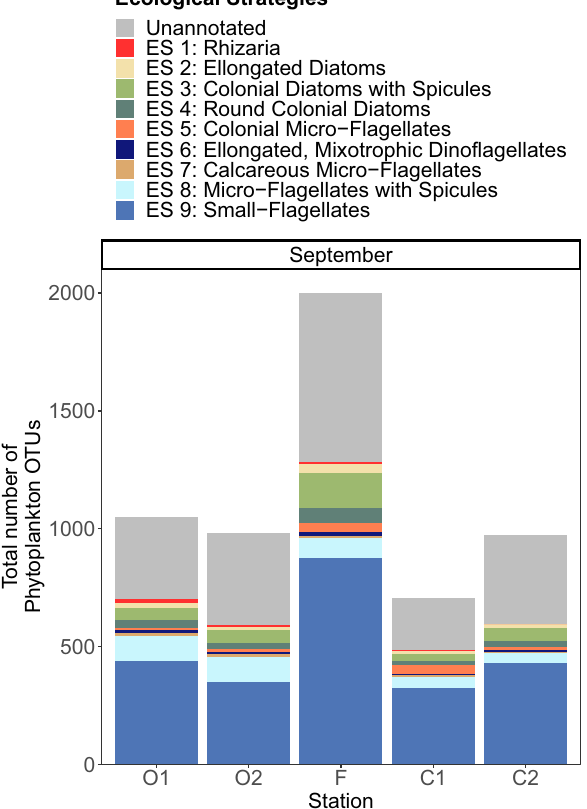
Figure 7. Phytoplankton richness within 9 ecological strategies of phytoplankton displayed across five sampling stations of the Iroise Sea in September 2015. Phytoplankton OTUs were sorted into distinct ecological strategies (see legend) represented by trait combinations (conserved within the groups) and when possible annotated with taxonomic affiliations. The gray area of the barplots represents the richness of the OTUs that could not be annotated with traits or with an ecological